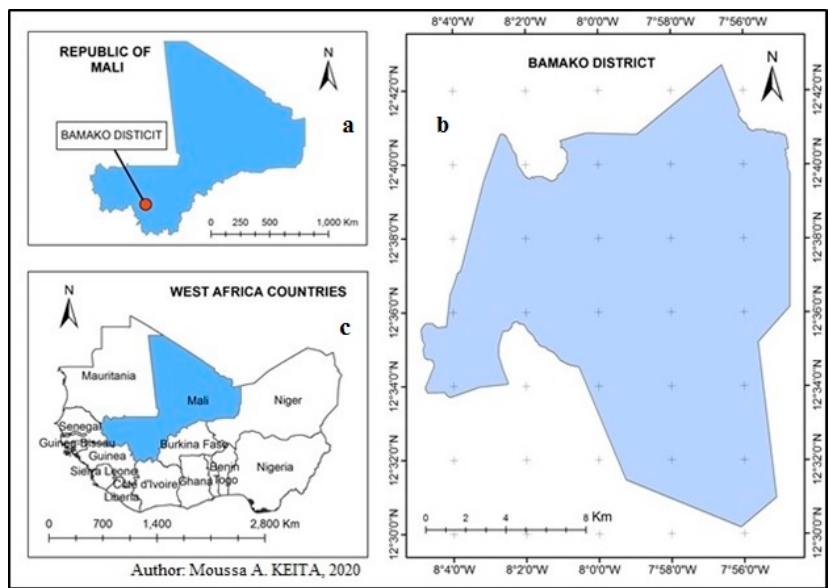
Figure 1. Study area location map: ( a ) Bamako district map; ( b ) map of the republic of Mali; ( c ) west Africa map.